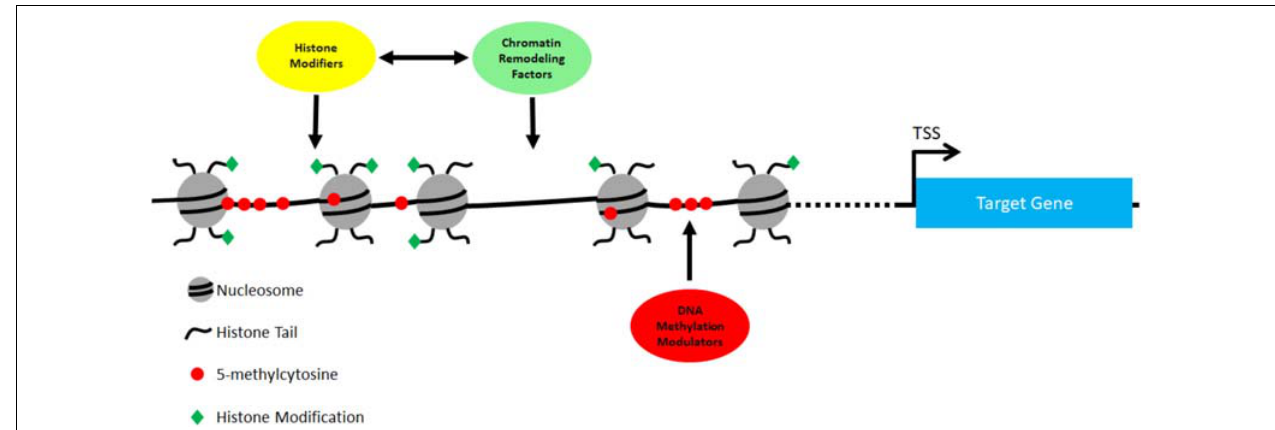
FIGURE 1 | All three types of epigenetic regulators act together to regulate gene expression in cNCCs. ATP-dependent chromatin regulators regulate the density and positions of nucleosomes in target sites, while histone modifiers regulates post-translational modifications in the histone tails. There are many examples showing the interaction, physical and functional, between chromatin regulators and histone modifiers (see main text). In addition, DNA methylation modulators regulate the status of DNA methylation at target sites to control gene expression in cNCCs.